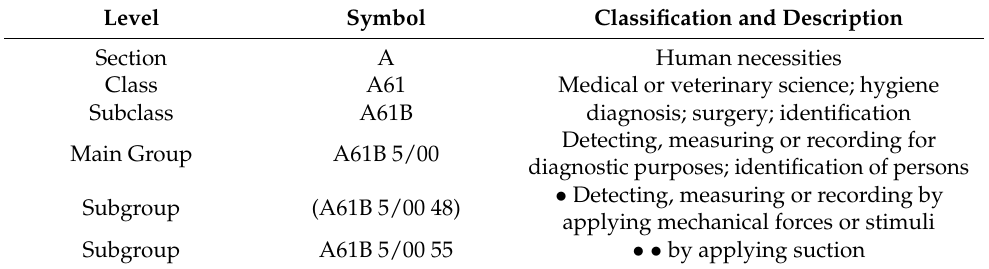
Table 2. Excerpt from the CPC definition showing all hierarchical levels up to the actual code A61B5/0055. Symbols in square brackets indicate subgroups discarded by parsing the code